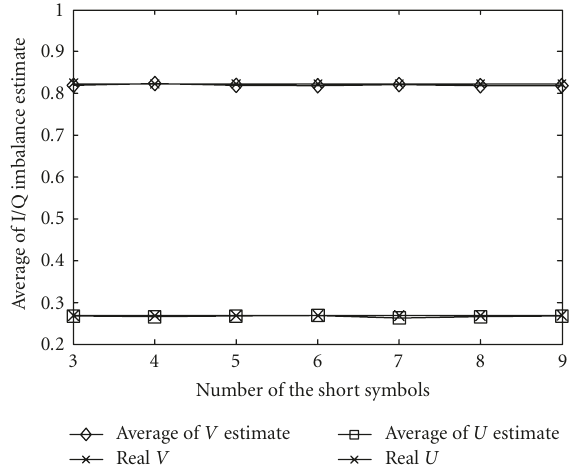
Figure 9: BER performance of a BPSK OFDM system with I/Q im- balance correction.